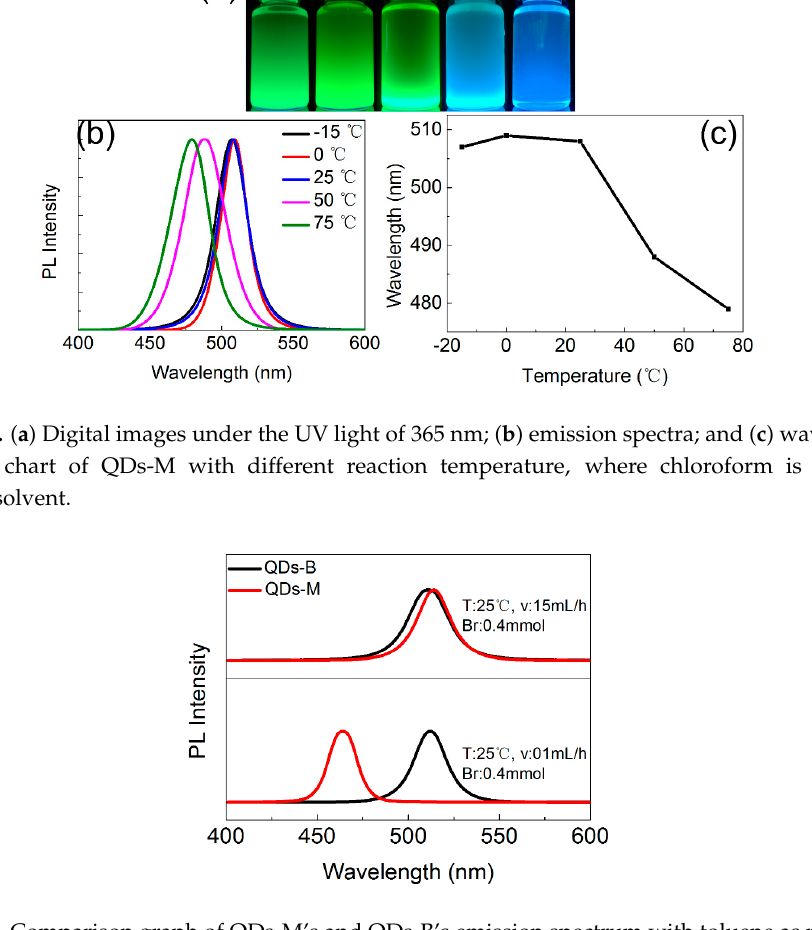
Figure A7. Comparison graph of QDs-M’s and QDs-B’s emission spectrum with toluene as nonpolar solvent. (T represents temperature, v represents precursor flow velocity and Br represents dosage of PbBr 2 .)